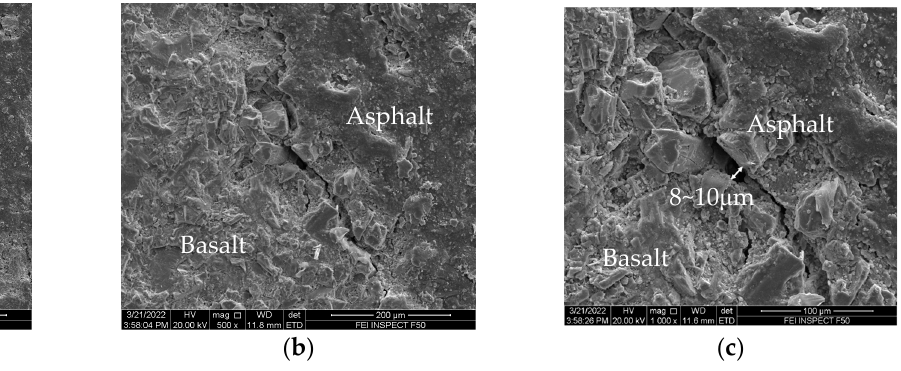
Figure 10. Asphalt-binder and steel slag interfacial imaging results: ( a ) ×200 magnification; ( b ) ×500